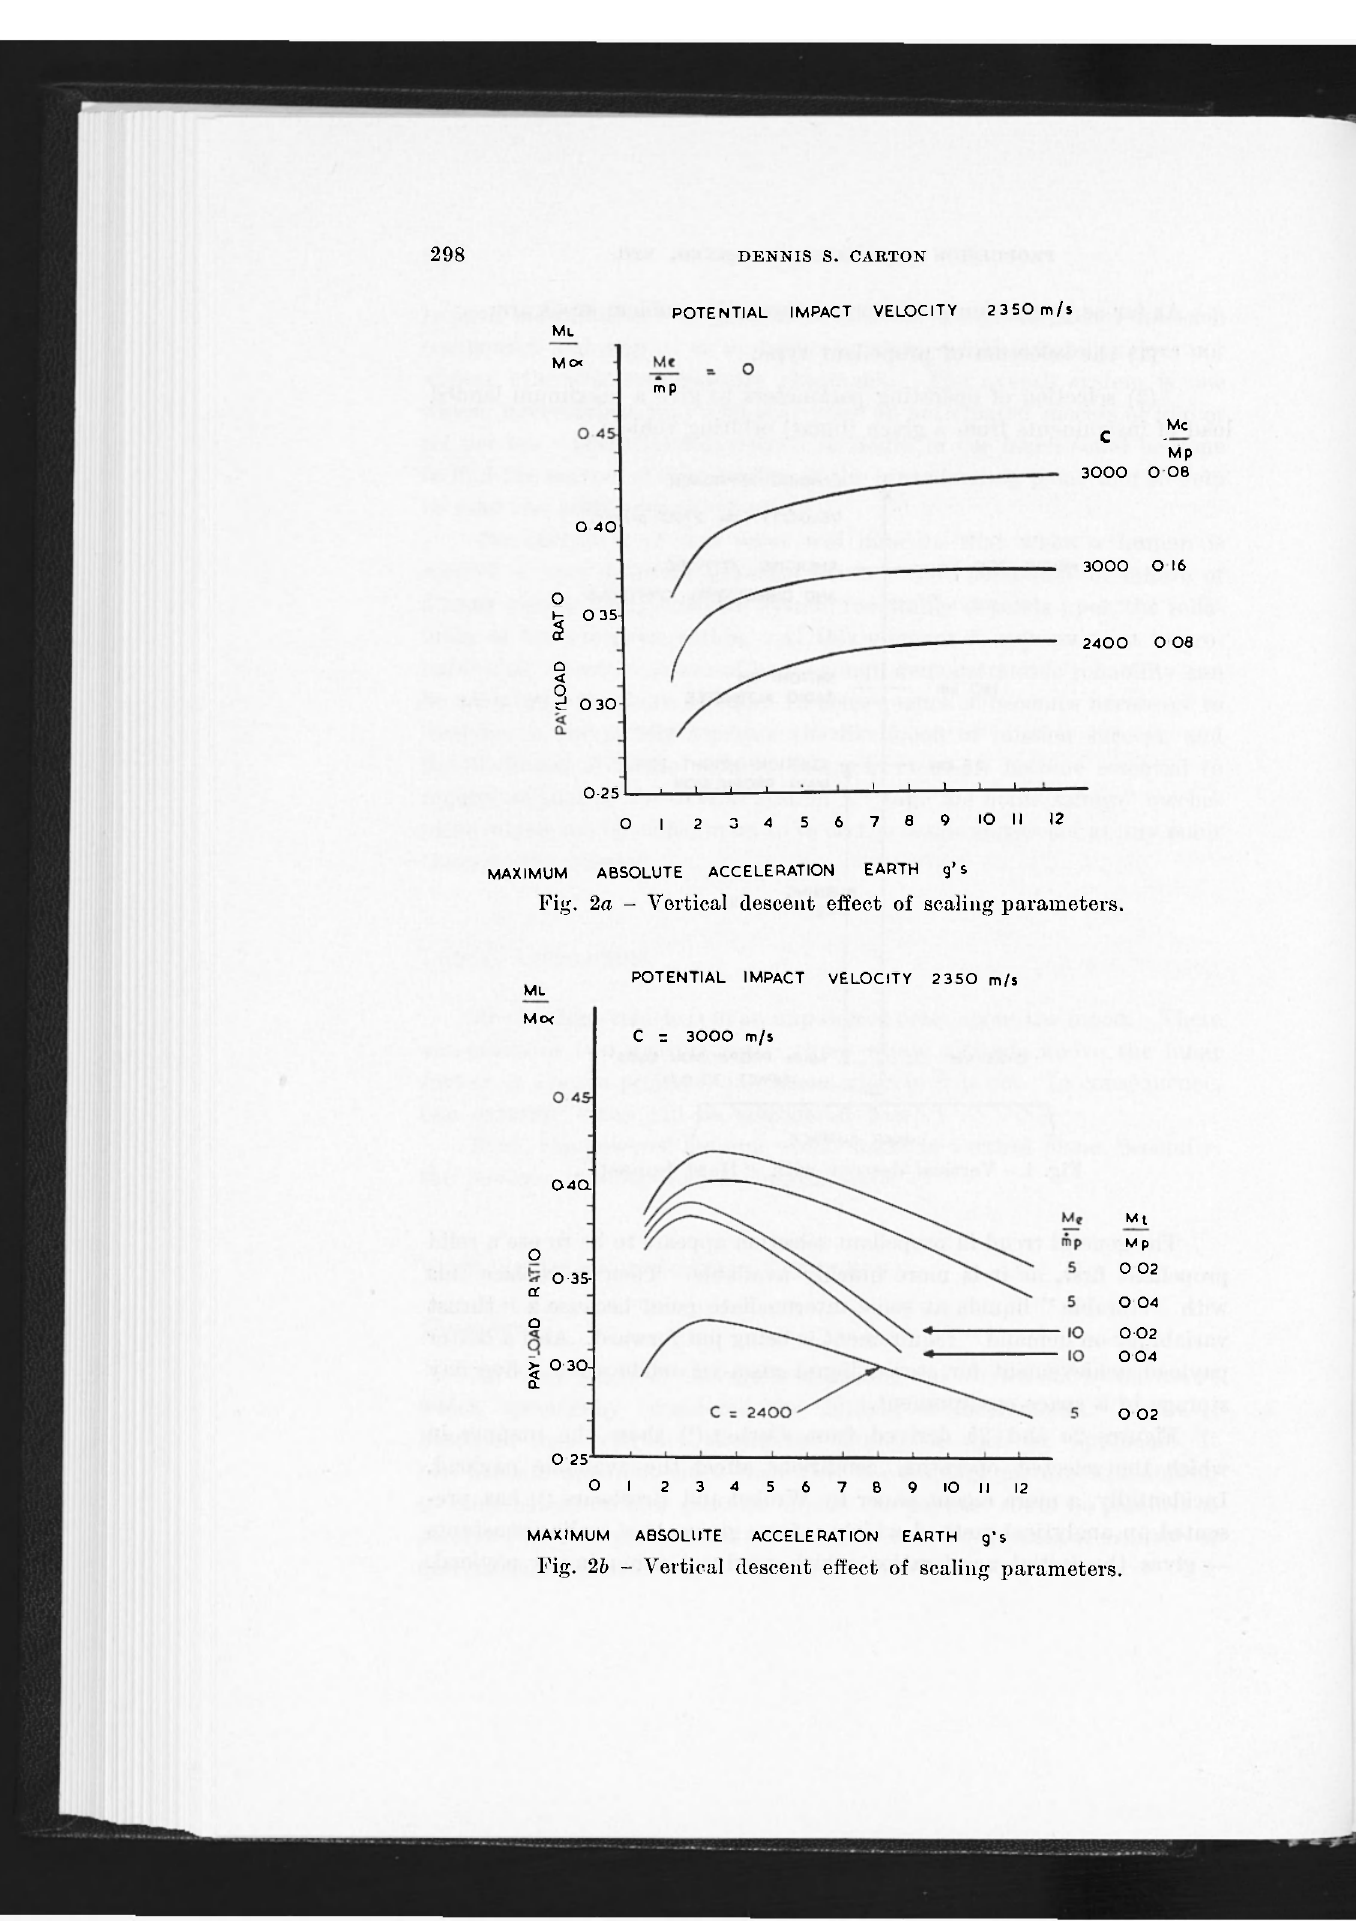
Fig. 2b - Vertical descent effect of scaling